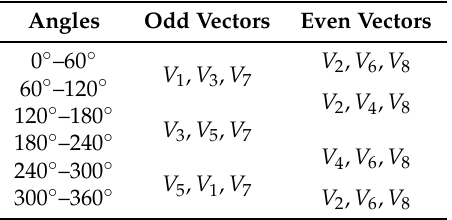
Table 3. Vectors used in the CCMV SVM